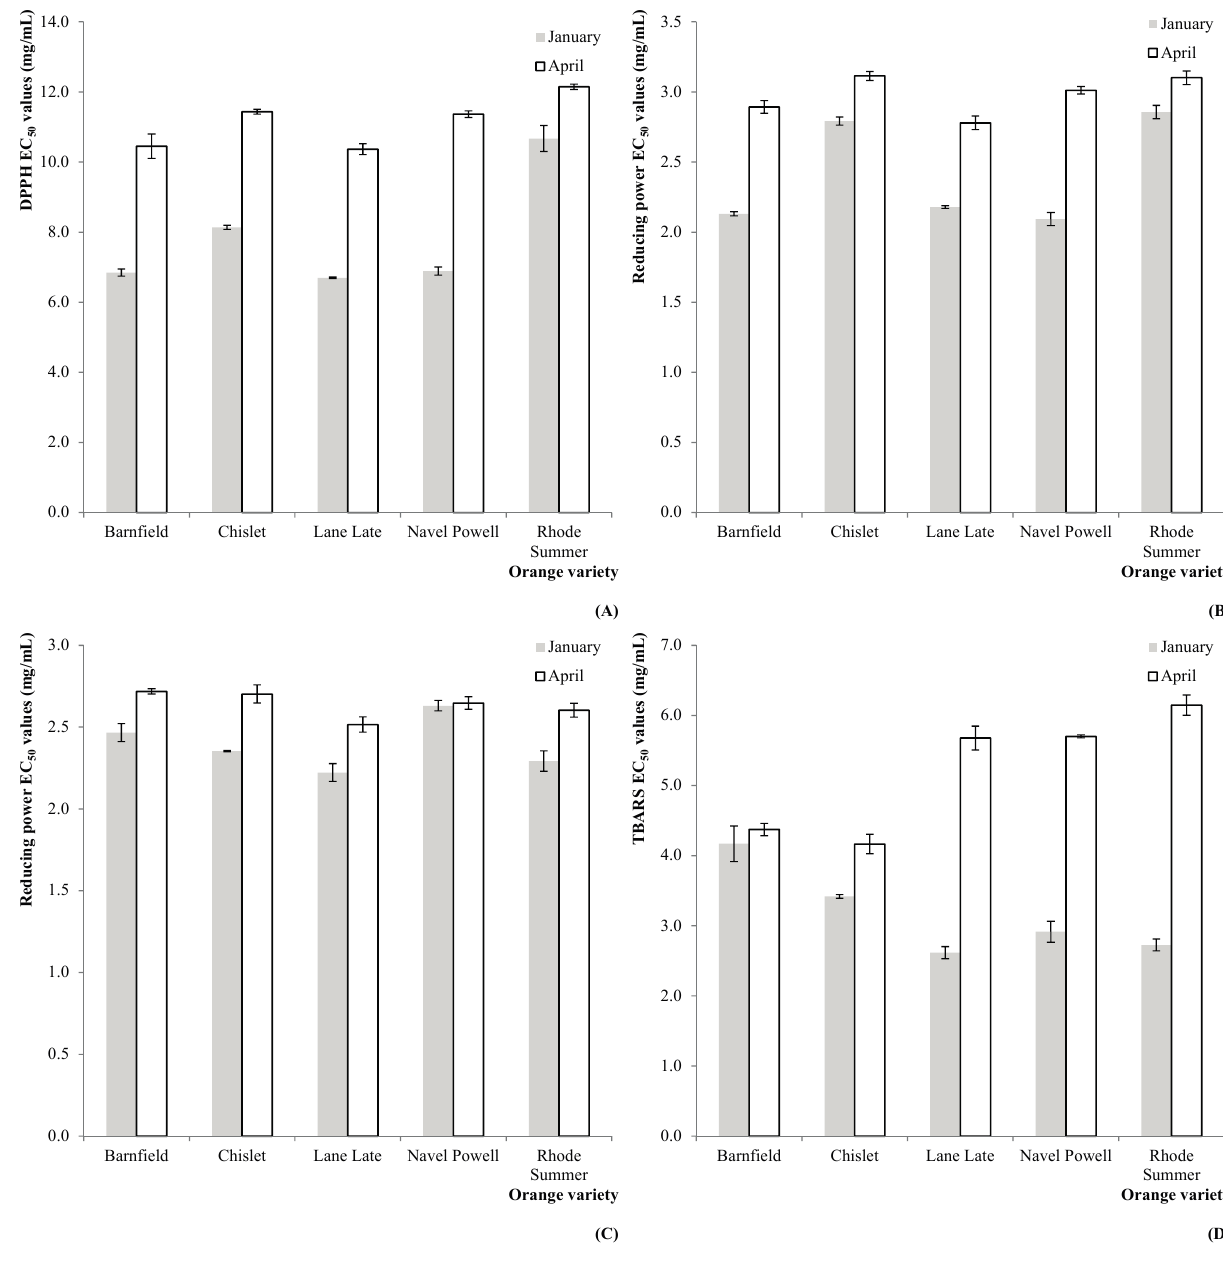
Figure 3. Estimated marginal mean plots representing the effect of HS on the antioxidant properties of C. sinensis fruits: ( A ) DPPH scavenging activity (2011); ( B ) reducing power (2011); ( C ) reducing power (2012); and ( D ) TBARS formation inhibition